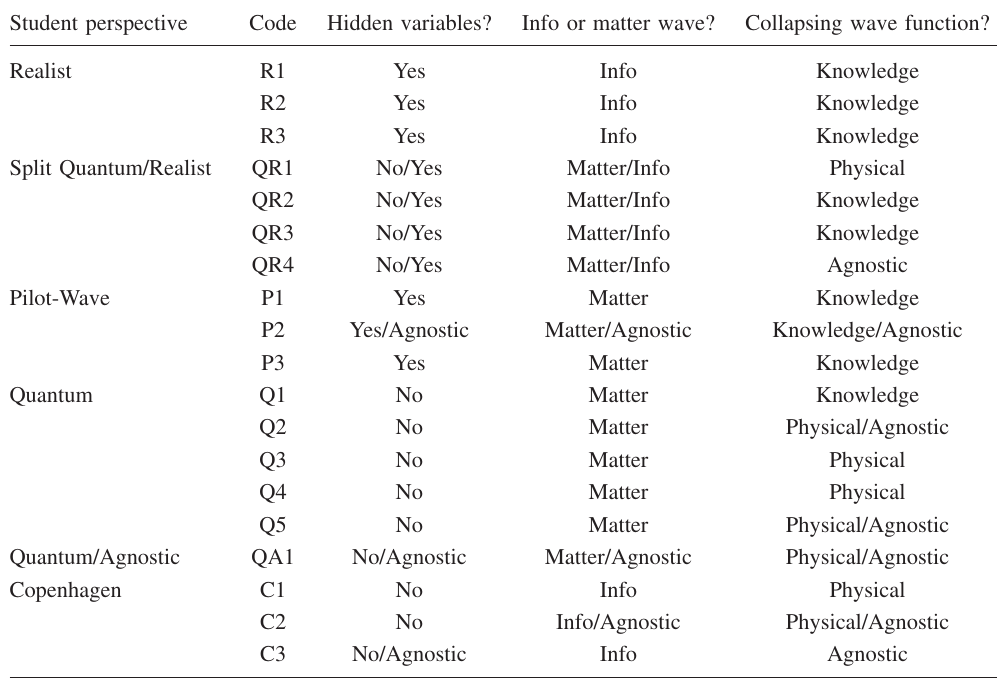
TABLE III. Summary of individual student interview responses with respect to three interpretive themes, grouped by overall